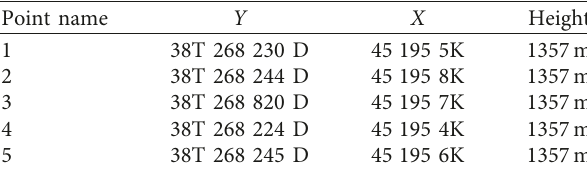
Table 2: Sample-C2 coal sample point coordinates.